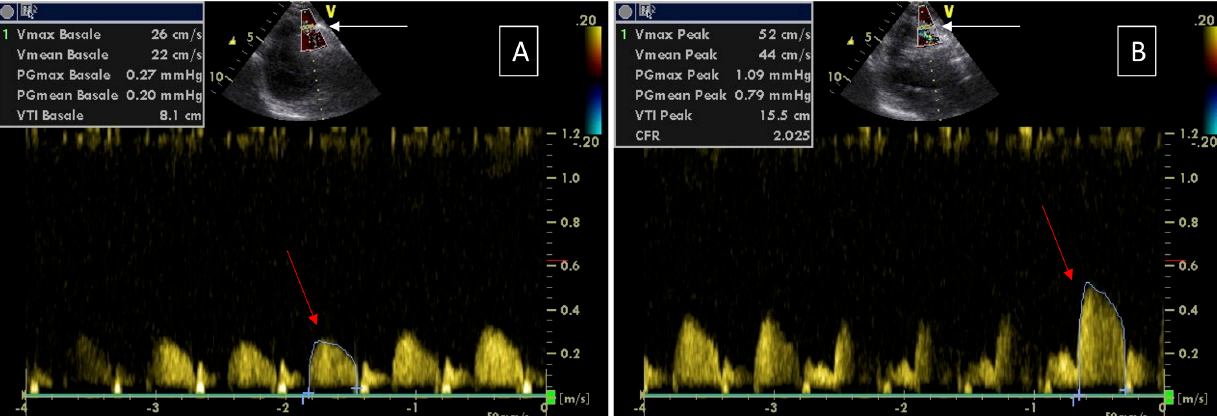
Figure 3. Coronary flow velocity is measured at rest (left, Panel A ) and during maximal hyperemia (right, Panel B ). In both conditions, pulsed Doppler echocardiography allows to measure the velocity of the blood flow in the distal part of the left anterior descending coronary artery (white arrows). To obtain coronary flow velocity reserve (CFVR), we calculate the ratio between diastolic peak velocity (cm/s) during maximal hyperemia and at rest (red arrows). In this specific patient, CFVR = 52/26 = 2.